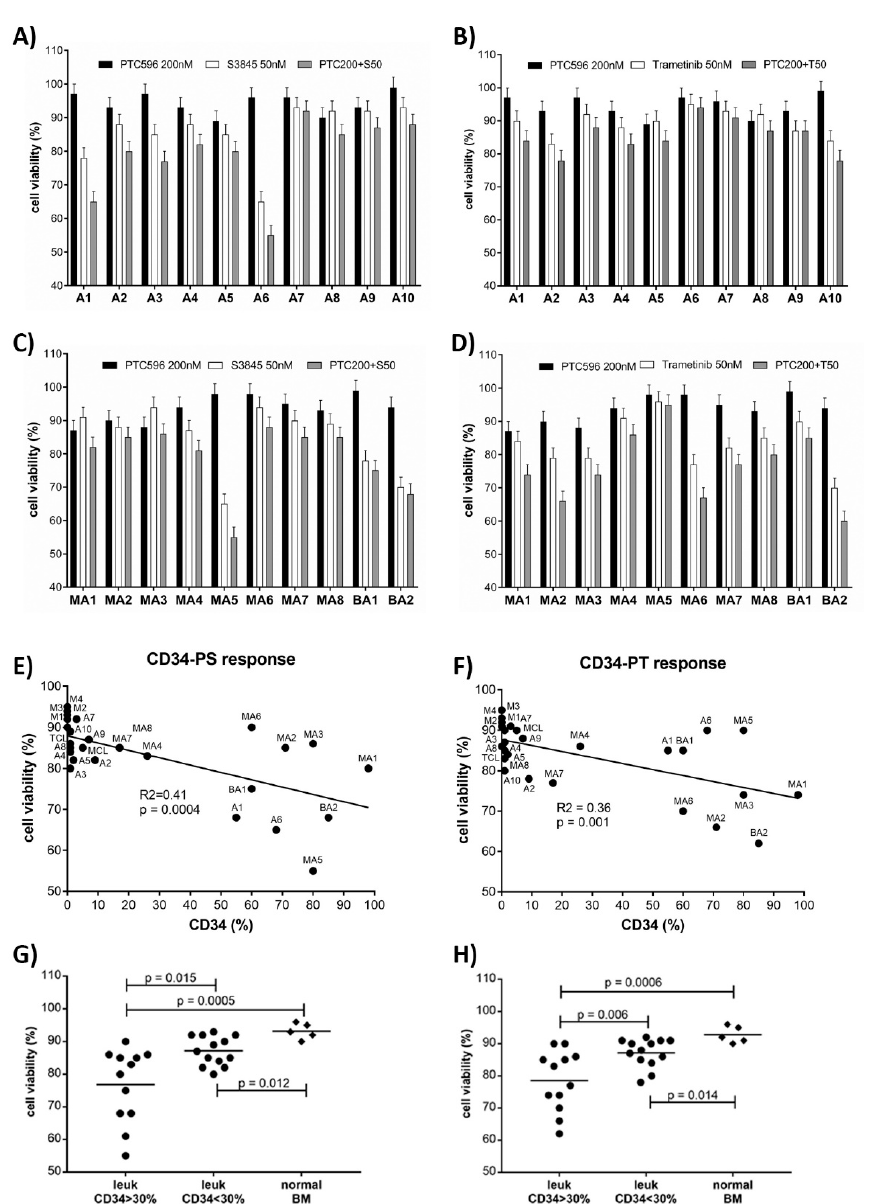
Figure 6. PTC596 combination treatment in patient samples in vitro. Cell viability as determined in AML, MDS-AML, and B-ALL cells treated for 20 h with single compounds and in combination with PTC596 and S63845 ( A , C , E , G ) or PTC596 and trametinib ( B , D , F , H ). Statistical significance of cell responses to combination treatment was analyzed in hematological samples correlated to CD34 positivity ( E , G ) and grouped into leukemic cells with CD34 > 30% or CD34 < 30% and normal bone marrow cells ( F , H ).